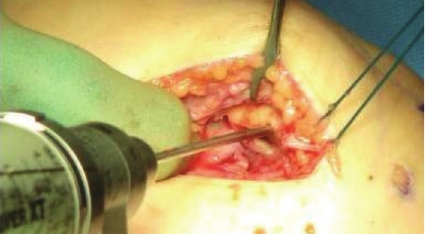
Figure 4: Patellar tunnels are prepared using a drill